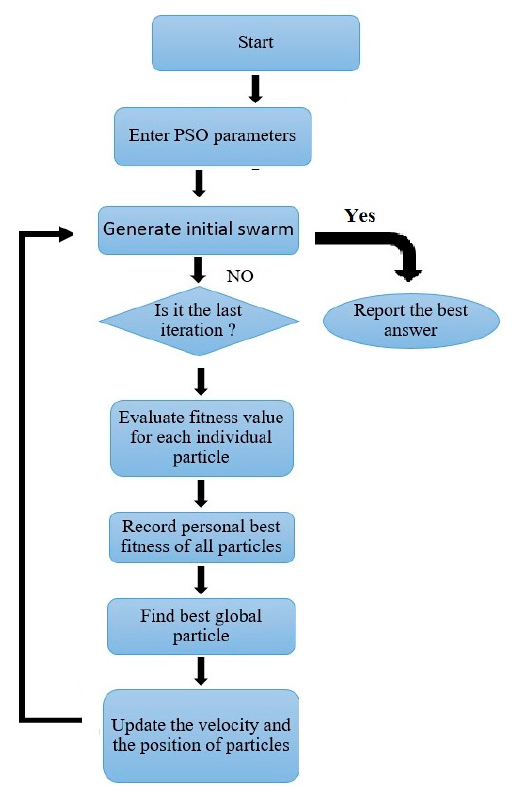
Figure 21. PSO sequential flowchart.